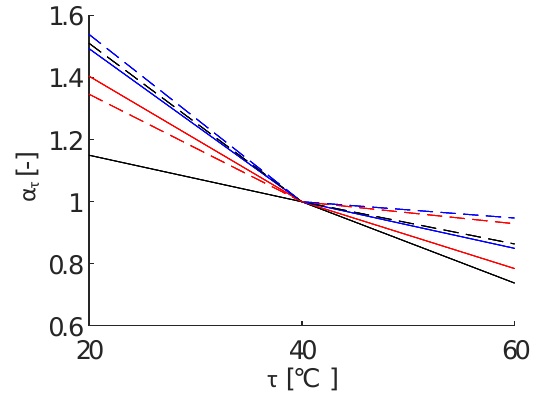
Figure 22: f µ 0 ( τ ) relative to f µ 0 at 40 ◦ C for each oil. HV at p Pe =50bar(black), HV at p Pe =65bar(black-dashed), HEES at p Pe =50bar(red), HEES at p Pe =65bar(red- dashed), HEES+ at p Pe =50bar(blue), HEES+ at p Pe =65bar(blue-dashed).